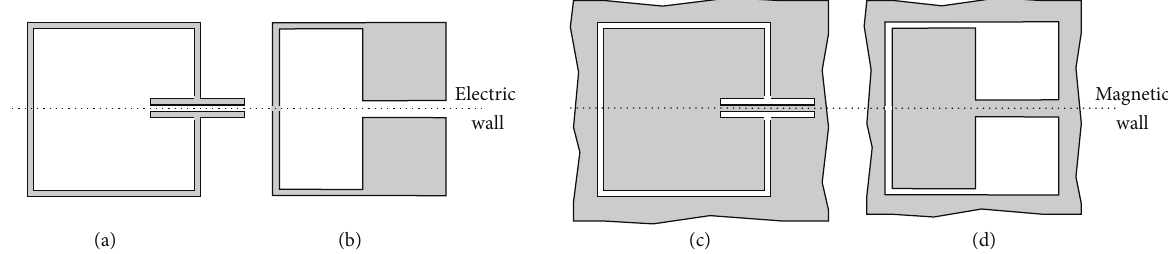
Figure 2: Typical topology of a capacitively loaded loop (a), a folded SIR (b), a complementary capacitively loaded loop (c), and a complementary folded SIR (d).